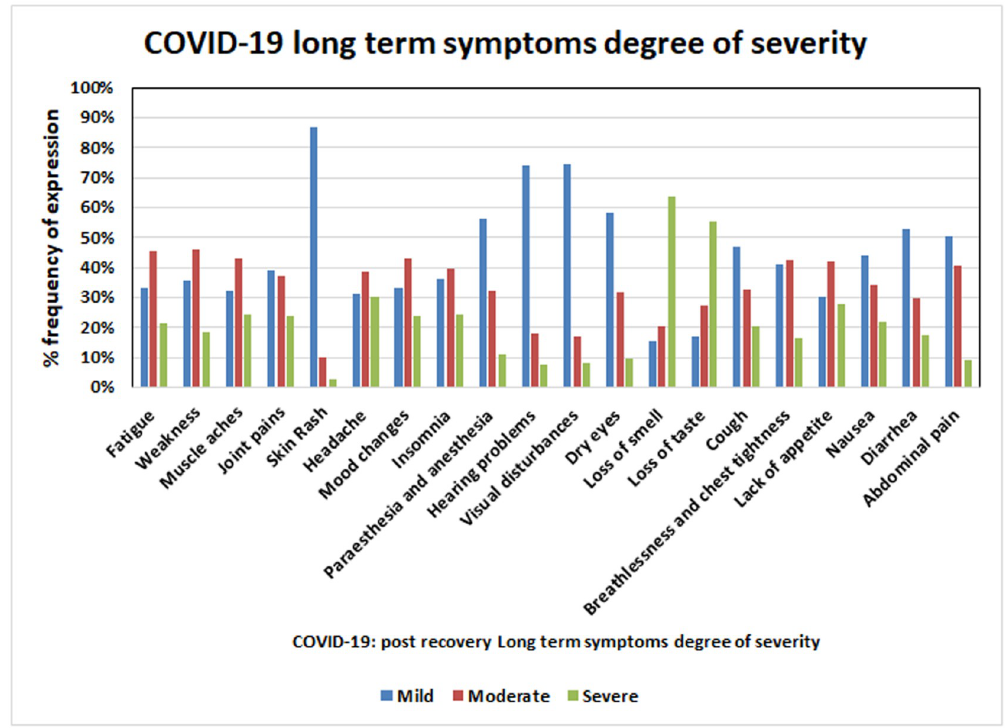
Fig 3. Degree of severity and frequency expression for different COVID-19 post recovery long term symptoms.